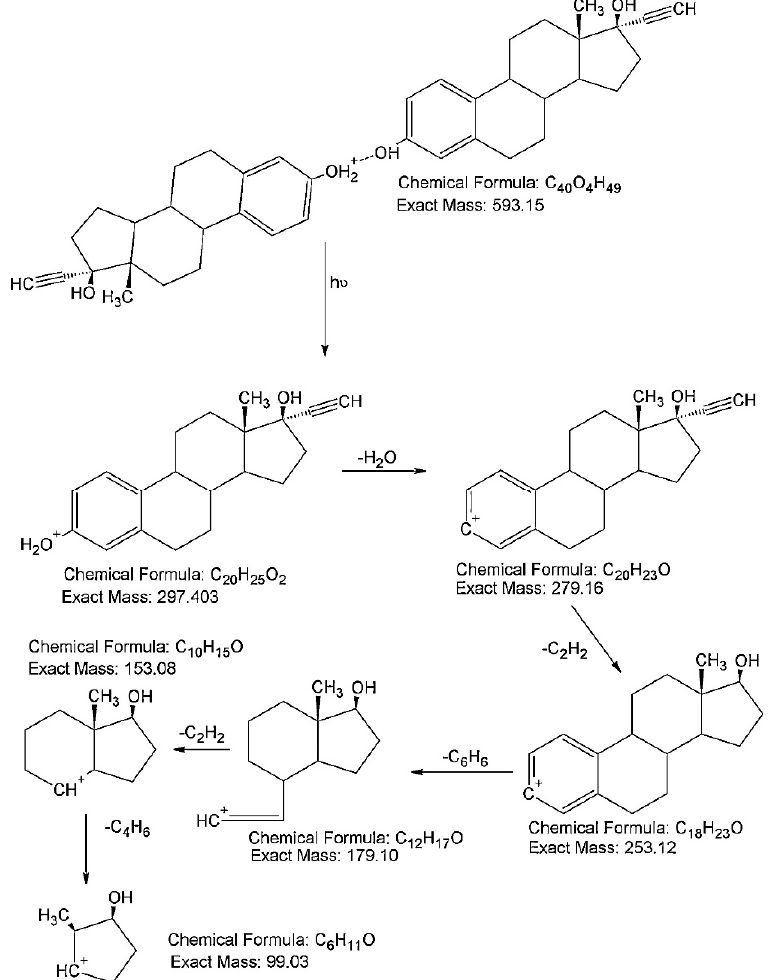
Figure 3. Mechanism for degradation of EE2 given 350 nm exposure. Reused with permission from reference [12]. Copyright Elsevier 2015.